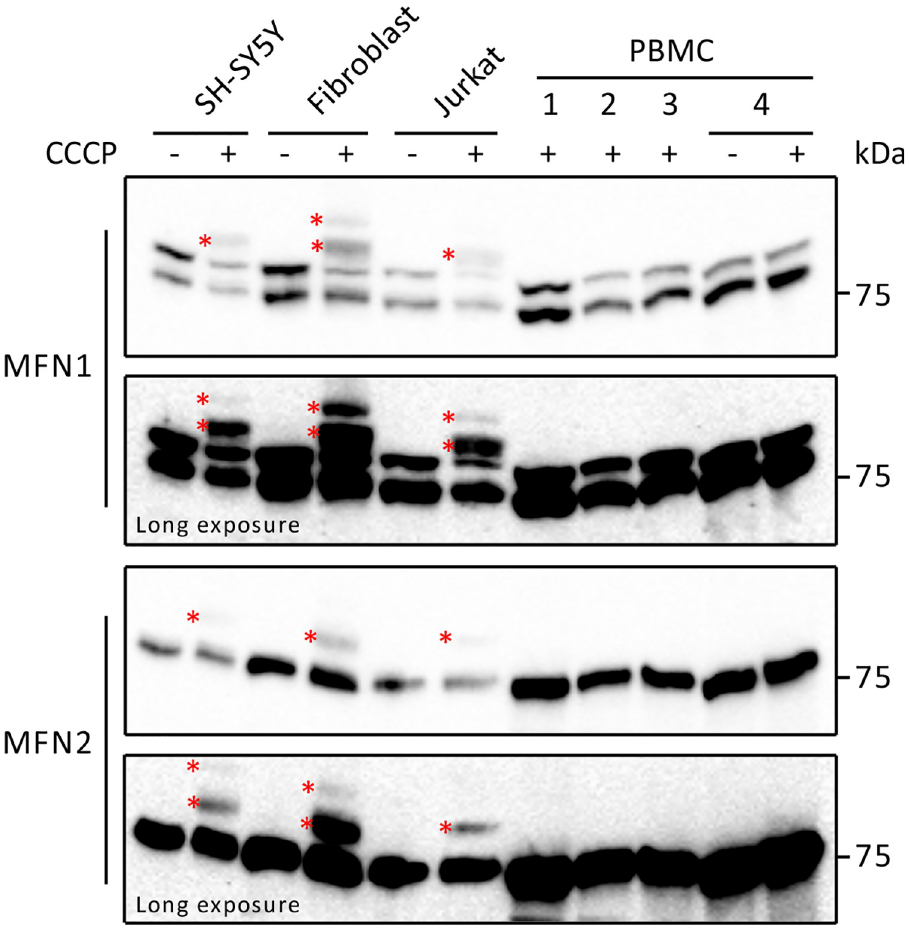
Fig 3. Analysis of CCCP-induced MFN ubiquitination in different cell types. SH-SY5Y, fibroblast, Jurkat and PBMC samples were left untreated or were treated with 20 μ M CCCP for 2 hours and analysed by western blotting with antibodies against MFN1 and MFN2. Asterisks indicate bands representing ubiquitinated MFN proteins. https://doi.org/10.1371/journal.pone.0259903.g003 cells. Confocal microscopy revealed TMRM-stained, red fluorescent mitochondria in Jurkat and PBMCs under basal condition (Fig 4). Addition of CCCP resulted in a rapid loss of the dye from the mitochondria in both cell types, indicating a rapid dissipation of the